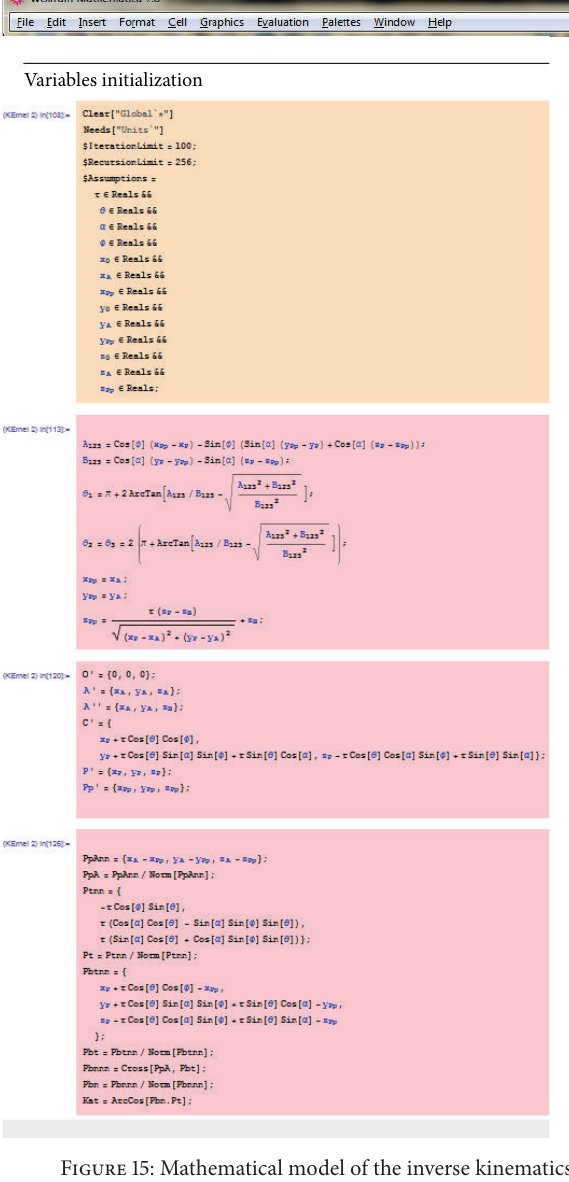
Figure 15: Mathematical model of the inverse kinematics implemented in Wolfram Mathematica computational